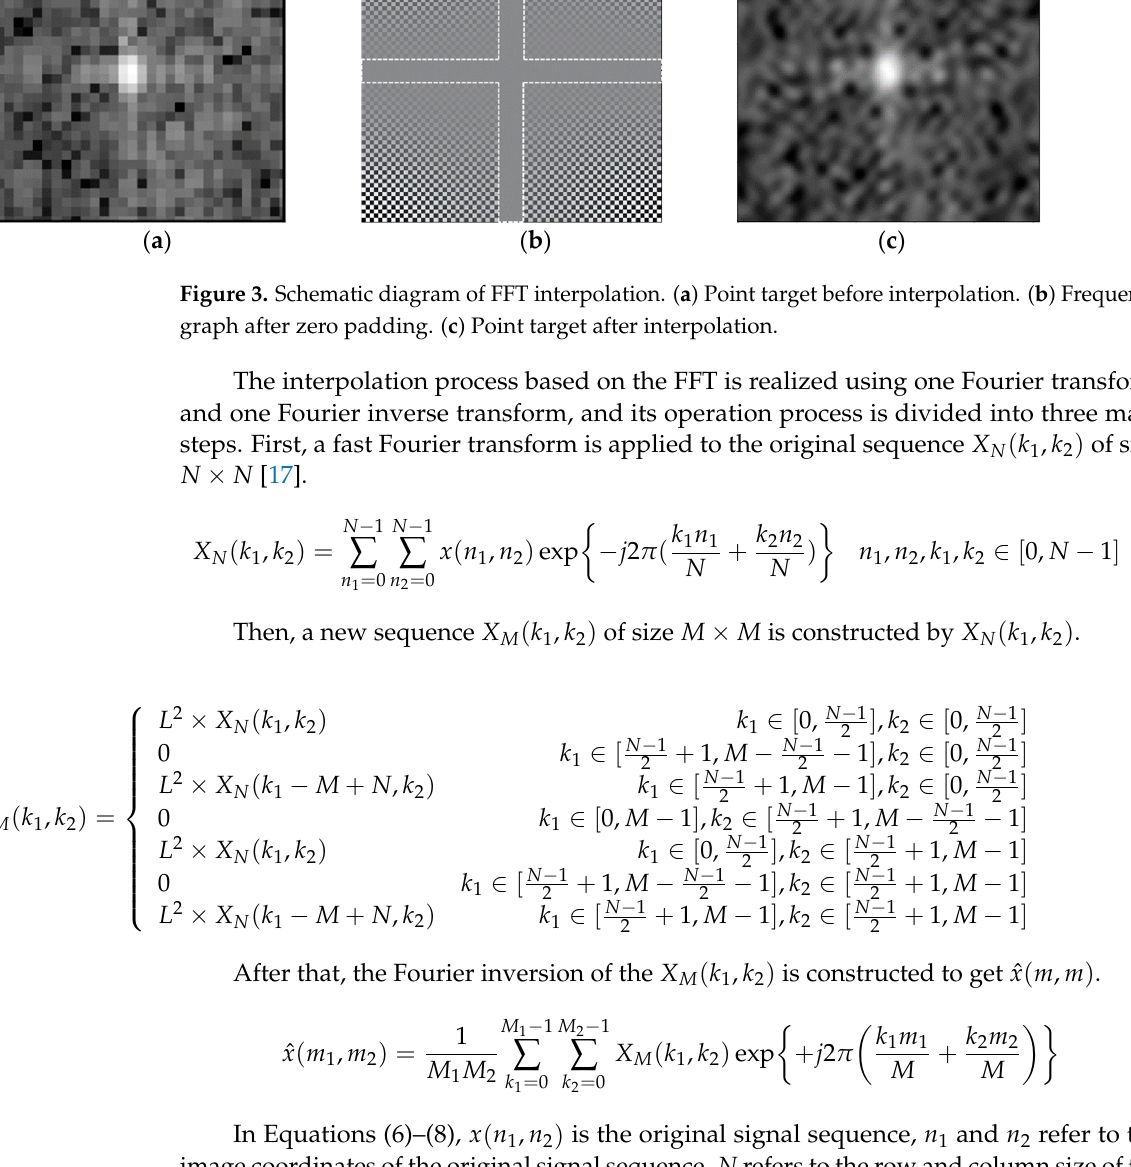
5 of 14 Figure 2. Schematic diagram of the bilinear interpolation method. The value taken at the place of (